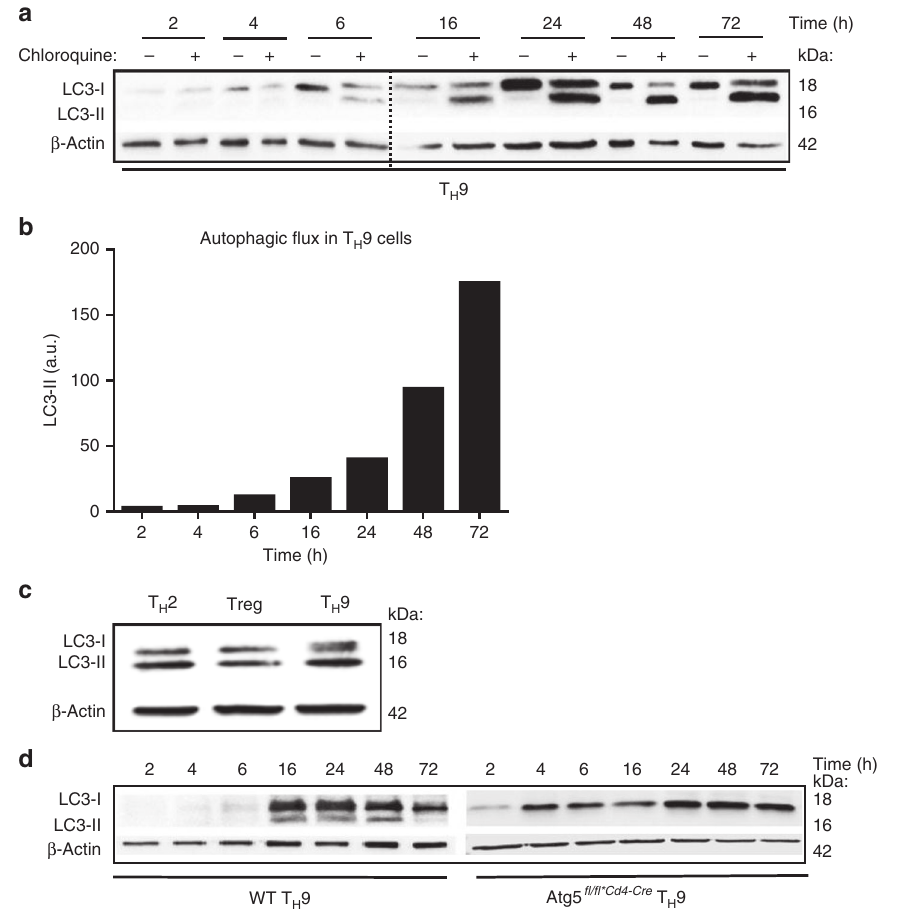
Fig. 2 Autophagy is active during T H 9 cell differentiation. a The conversion from endogenous LC3-I to LC3-II, the autophagosome marker, during T H 9 cell differentiation was monitored by western blot in the presence and absence of chloroquine. The amounts of LC3-II on this immunoblot were used to determine the autophagic fl ux in T H 9 cells. b The autophagic fl ux during T H 9 cell differentiation was determined by calculating the differences in the amount of LC3-II between cells cultured with or without the lysosomal inhibitor chloroquine, thus representing the amount of LC3 that is delivered to lysosomes for degradation. c Immunoblot analysis of LC3-II expression in T H 2, Treg and T H 9 cells, differentiated for 3 days. d Western blot of LC3-II in Atg5-de fi cient cells compared to WT cells during T H 9 cell